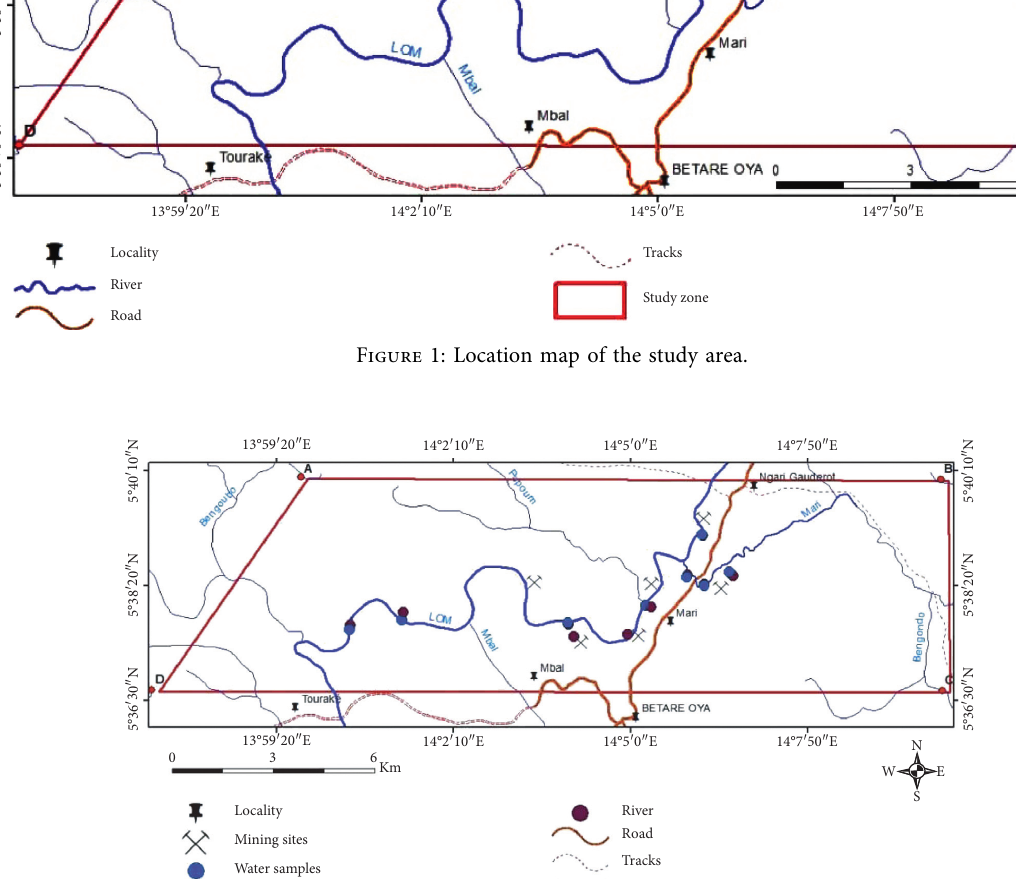
Figure 2: Sampling